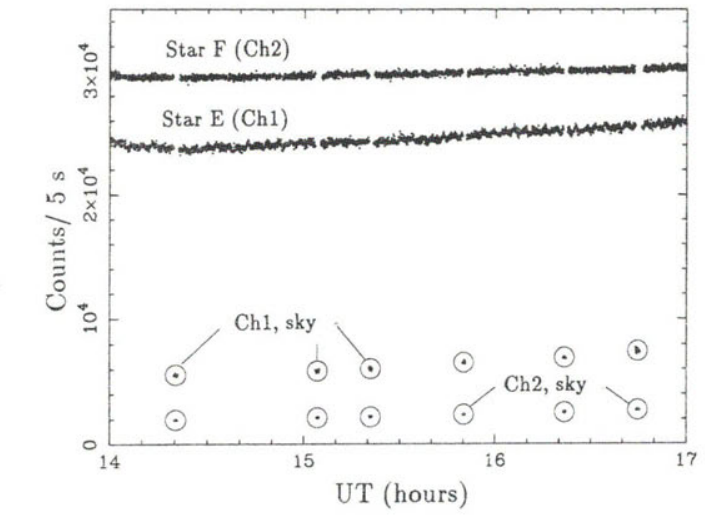
Fig. 3. Three hours of high-speed photometry on two stars obtained at MJUO just prior to the 1995 WET run XC0V12. Star E is the pulsating DAV white dwarf, L 19-2, while star F is a nearby constant comparison star. The circled points are the sky counts in each